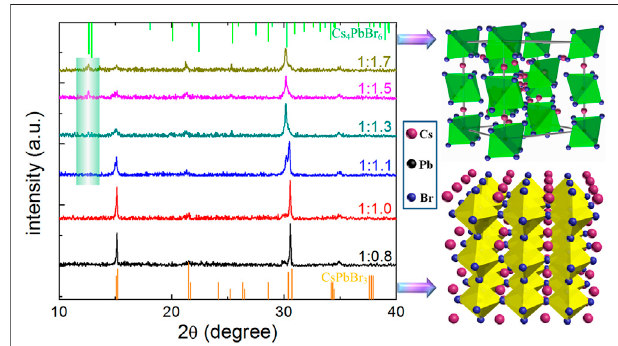
FIGURE 2 | Bragg-Brentano X-ray diffraction patterns for the corresponding all-inorganic perovskite fi lms with different molar ratios of PbBr 2 and CsBr, such as 1:0.8, 1:1.0, 1:1.1, 1:1.3, 1:1.5, 1:1.7, respectively. The right of the fi gure shows the crystal structures of CsPbBr 3 (bottom) and Cs 4 PbBr 6 (top) perovskite.